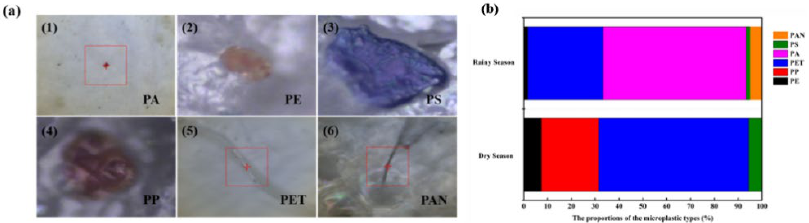
Figure 7. ( a ) Micrographs of the predominant microplastics; ( b ) the proportions of various microplastic types found during different seasons in the Pearl River Delta. Note: PA, polyamide; PE, polyethylene; PS, polystyrene; PP, polypropylene; PET, polyethylene terephthalate; and PAN, polyacrylonitrile.